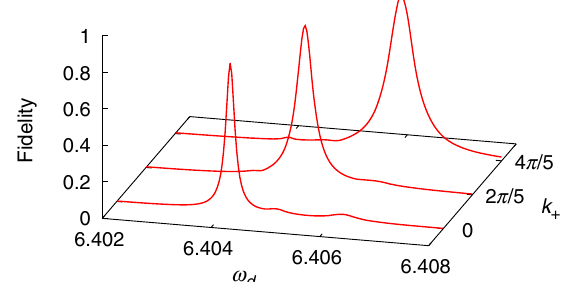
FIG. 5. Fidelities to the j k i states defined in Eq. (25) versus þ drive frequency ω in case only the first of N ¼ 5 cavities is d driven and with periodic boundary conditions. Same parameters as in Fig.